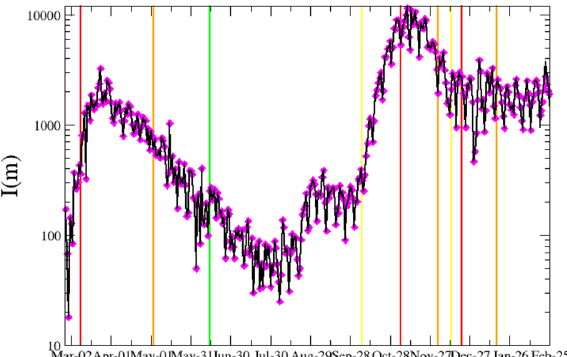
Figure 1. Black continuous lines represent the daily incidence of COVID-19 for the Lombardy from 02/24/2020 up to 02/24/2021. Color vertical lines indicate the starting time of different containment measures, which combines lockdown restrictions and closures with measures such as testing policy and contact tracing, etc. We adopt a color code ranging from red, orange, yellow up to green as a rough indicator of the severity of these restrictions, decreasing from red to green, i.e strong restrictions are imposed in the temporal period after a red line whereas weak ones after a green one. Magenta diamonds represent the result of numerical simulations 0.15 , a 6.2 τ , provided by the LL maximization R c µ implementing the best estimate for and , for τ = = { } { } 250 procedure. The overlap with experimental data is achieved setting I ( 0 ) =